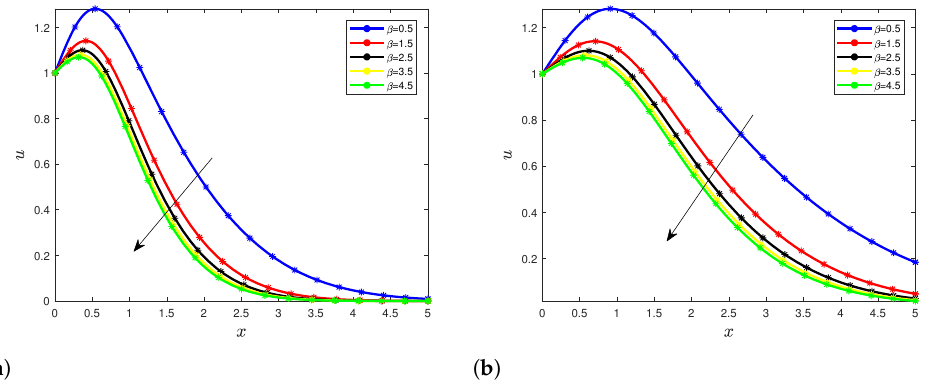
Figure 7. Dynamics of the fractional diffusion reaction equation with various orders with, respectively, τ = 0.5 ( a ) with α = 0.65 and τ = 1.5 ( b ) with α = 0.95.